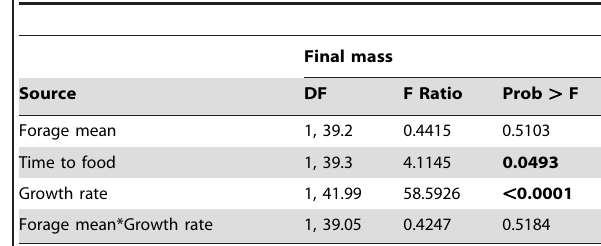
Table 2. F-statistics and P-values for the random-effects GLM of behaviors associated with the final body mass of tadpoles reared in groups.